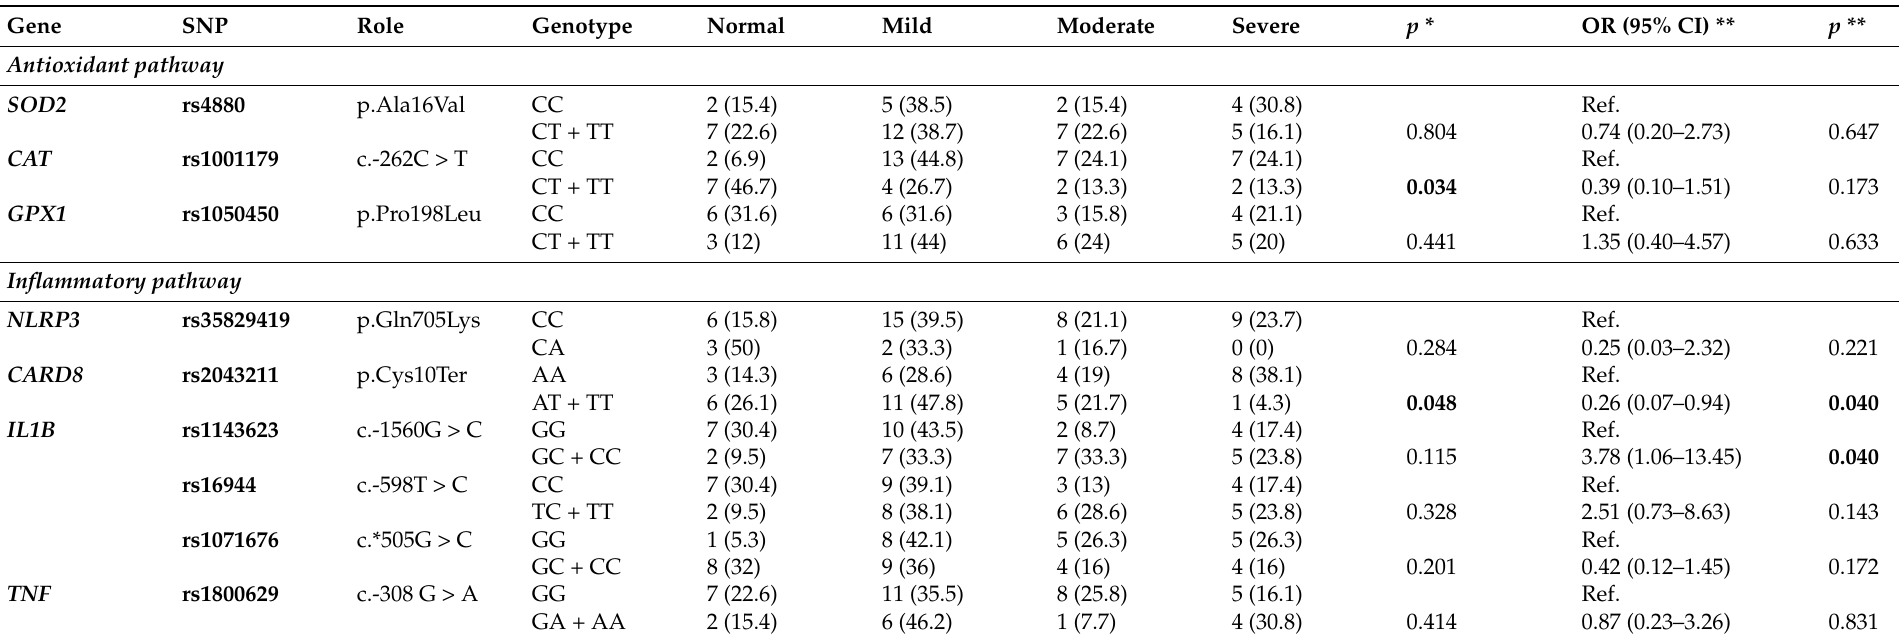
Table 3. Association of common polymorphisms with overall MRI assessment.